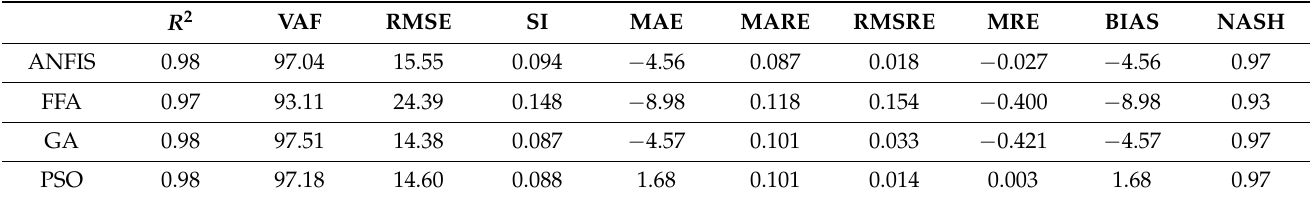
Table 3. Summary of model accuracy indicator test for the testing data set (for the first combination data set), which was calculated in Excel.